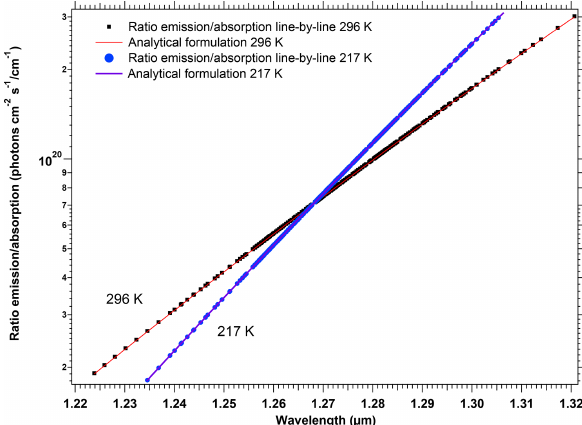
Figure A5. For two different temperatures (296 and 217K), the ra- tios of our calculated emission rate to the HITRAN line strength SS are plotted (respectively, black and blue dots) for all 375 transi- tions of HITRAN table (between 1.2238 and 1.32068µm). The solid lines (respectively, red and blue) are computed from the analytical formula (Eq. A13) on a grid of wavelength–wavenumber using the same scale on the left as the ratio of emission to line strength in units of photonscm − 2 s − 1 / cm − 1 , where cm − 1 is a wavenumber